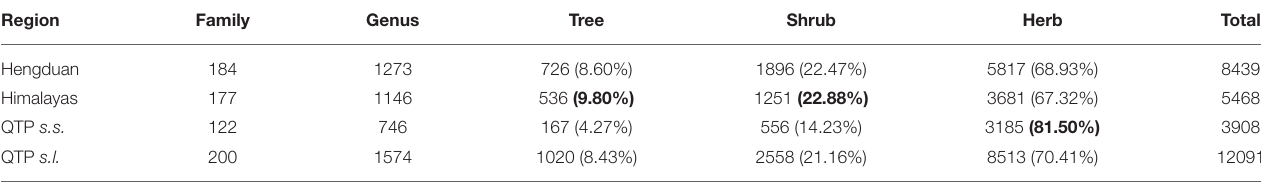
TABLE 1 | The basic floristic diversity of the Hengduan Mountains, the Himalayas, the Qinghai-Tibet Plateau s.s. , and the Qinghai-Tibet Plateau s.l . Region Family